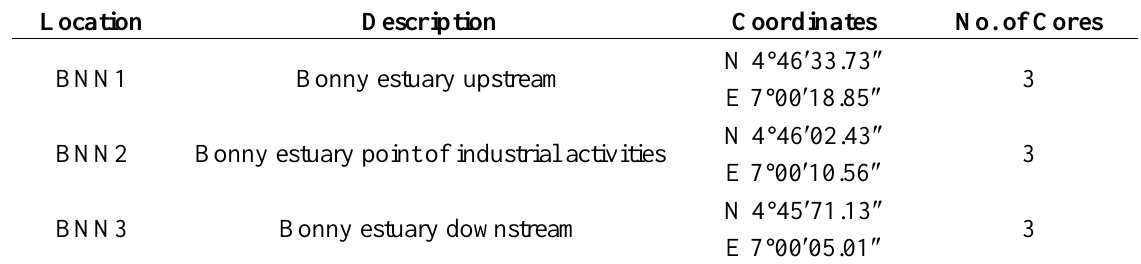
Table 1. Sediment sampling points in the Bonny